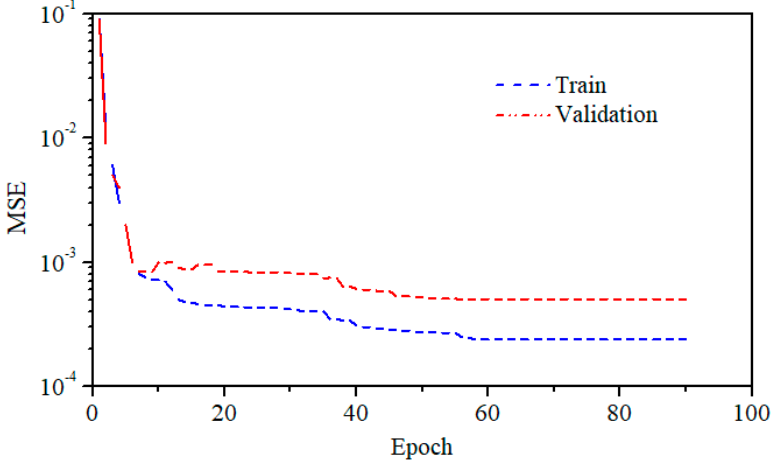
Figure 3. The MSE with respect to the number of neurons in the hidden layer.